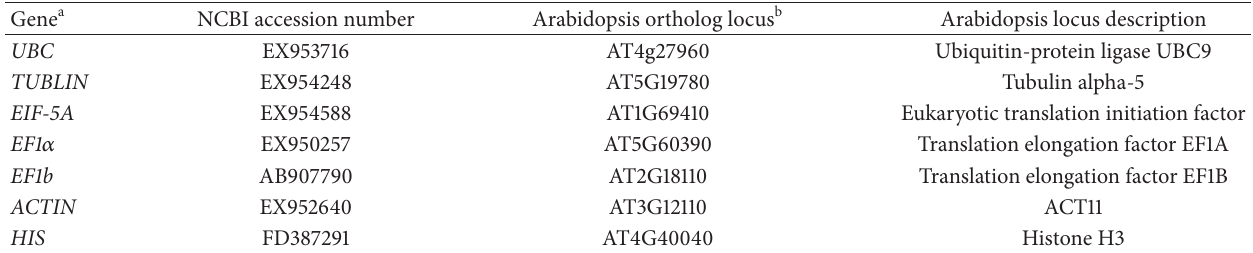
Table 1: Description of Iris. lactea var. chinensis reference genes for RT-qPCR.